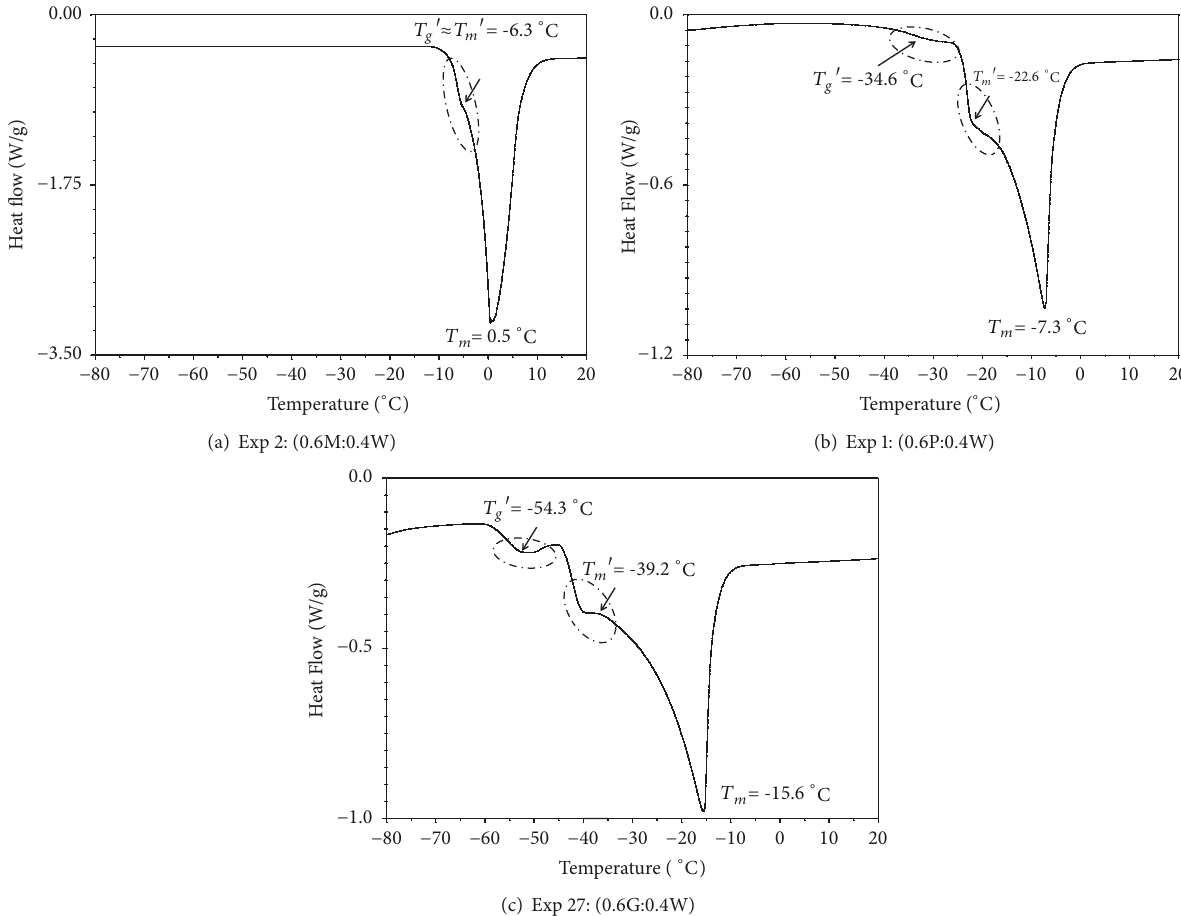
a single transition by DSC analysis [20, 30, 32, 43,